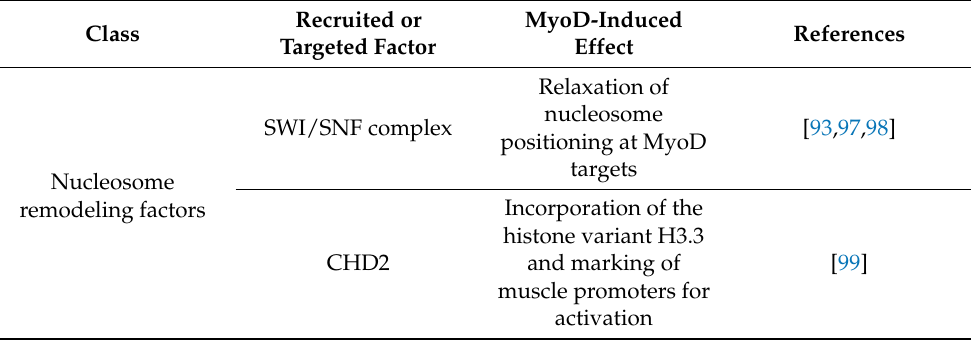
Table 1. Key factors exploited by MyoD for reprogramming the chromatin